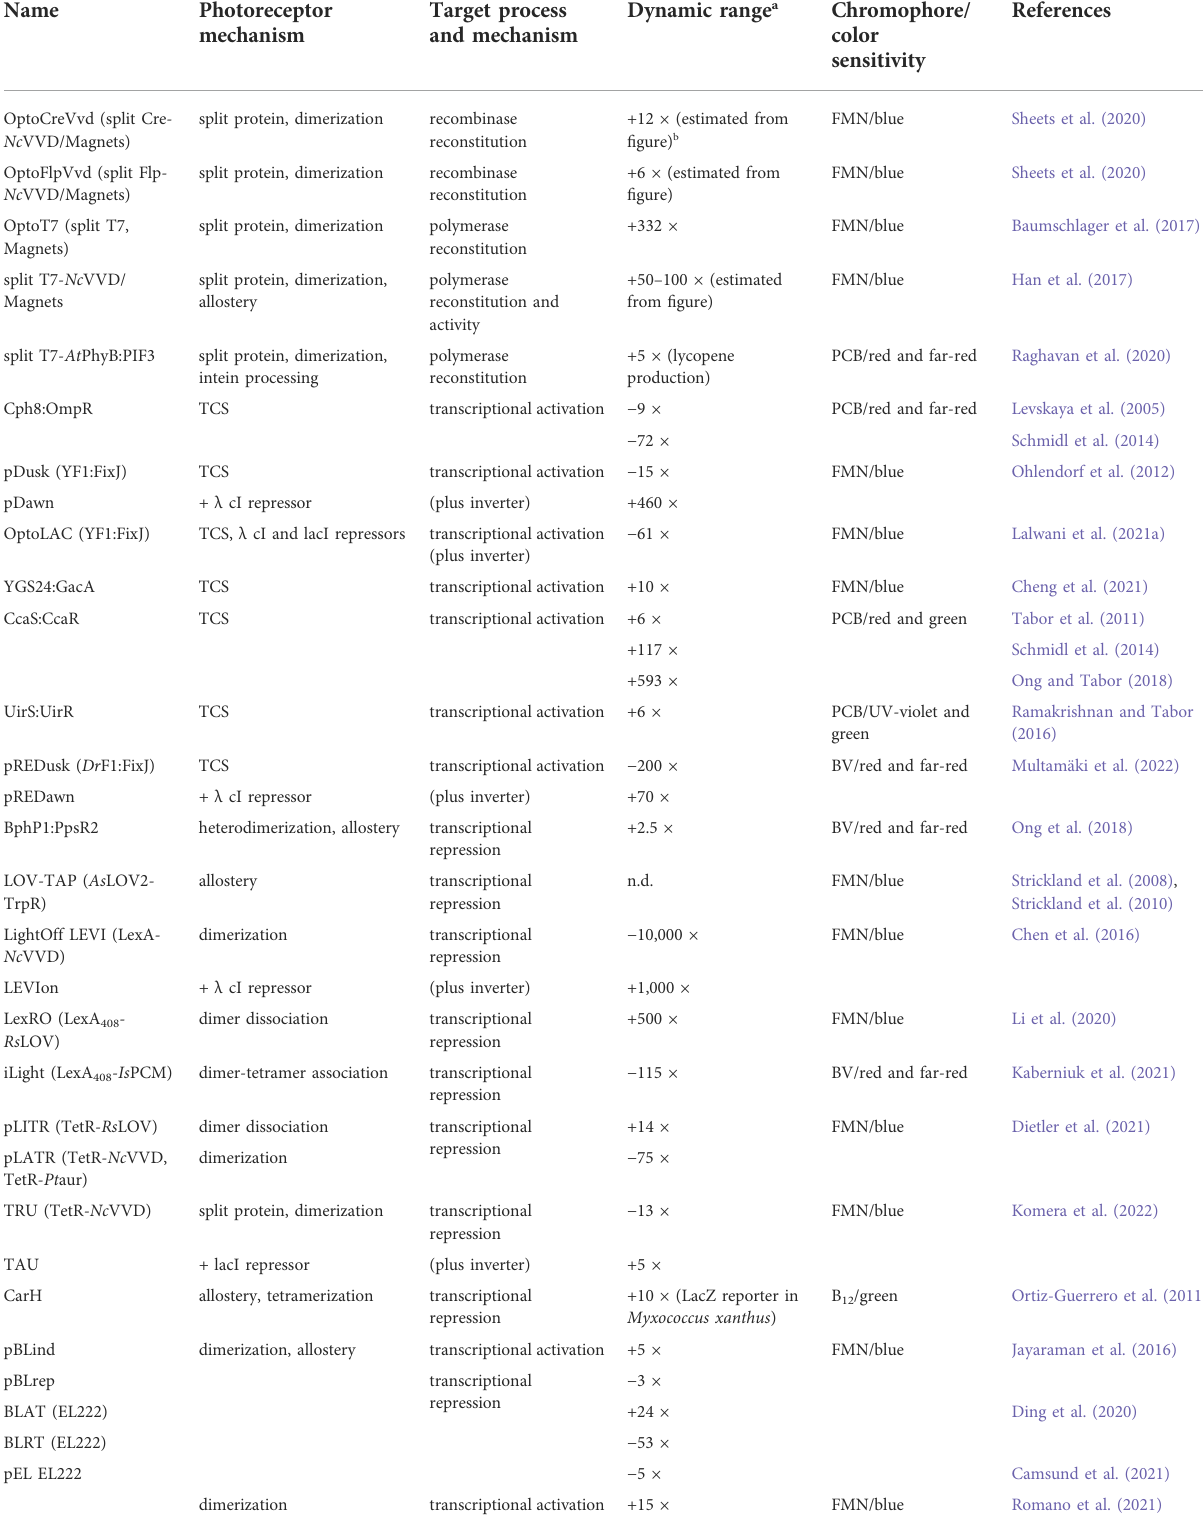
TABLE 1 Strategies for light-regulated gene expression in